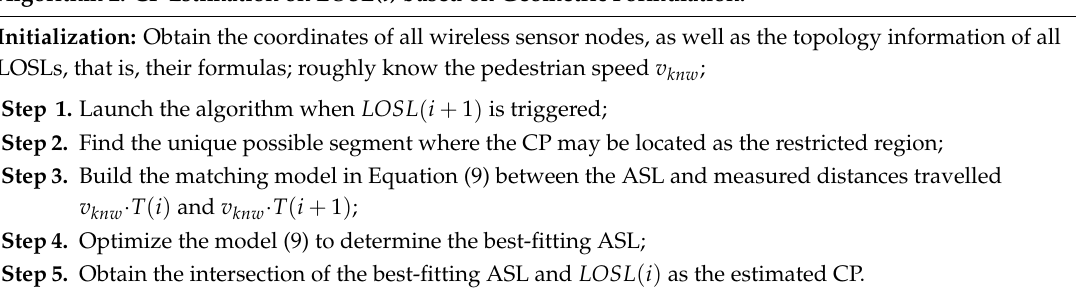
Algorithm 2: CP Estimation on LOSL ( i ) based on Geometric